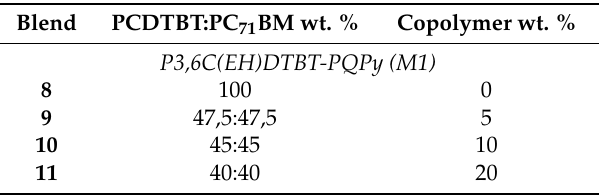
Table 3. Composition of the different blends studied.